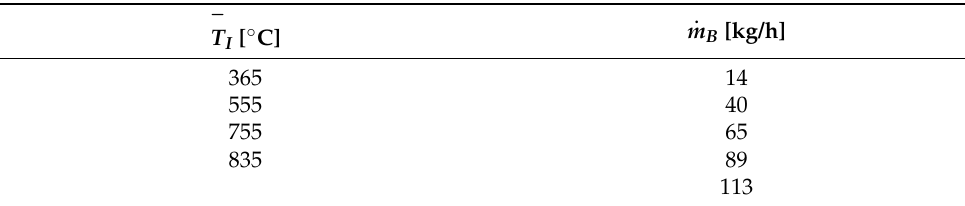
Table 2. Central variation parameters: average inventory temperature (T I ) and bypass mass flow . rate ( m B ).